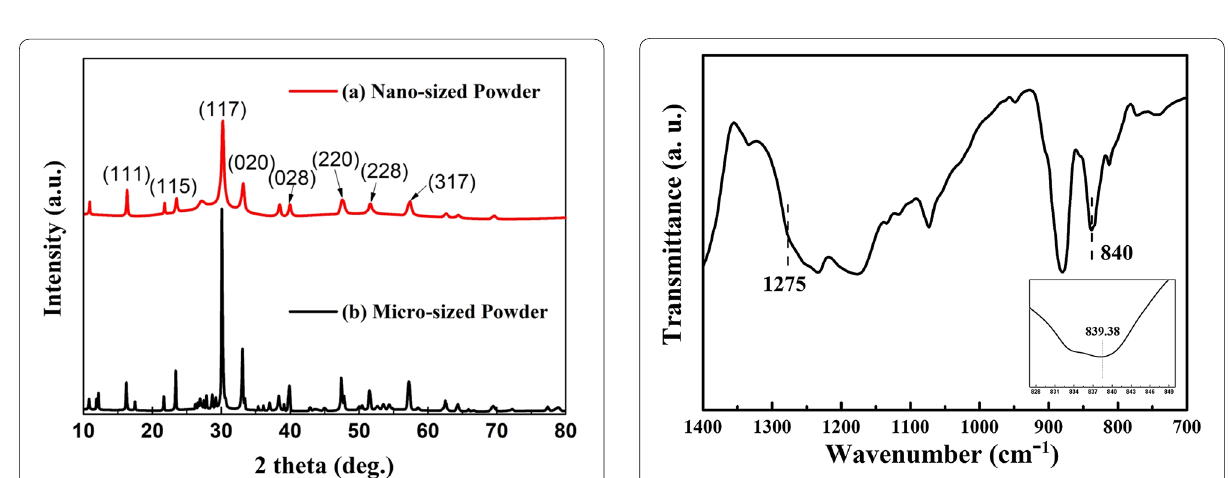
Fig. 4 X-ray diffraction (XRD) patterns of powders: a nano-sized BLT powder and b Micro-sized BLT powder